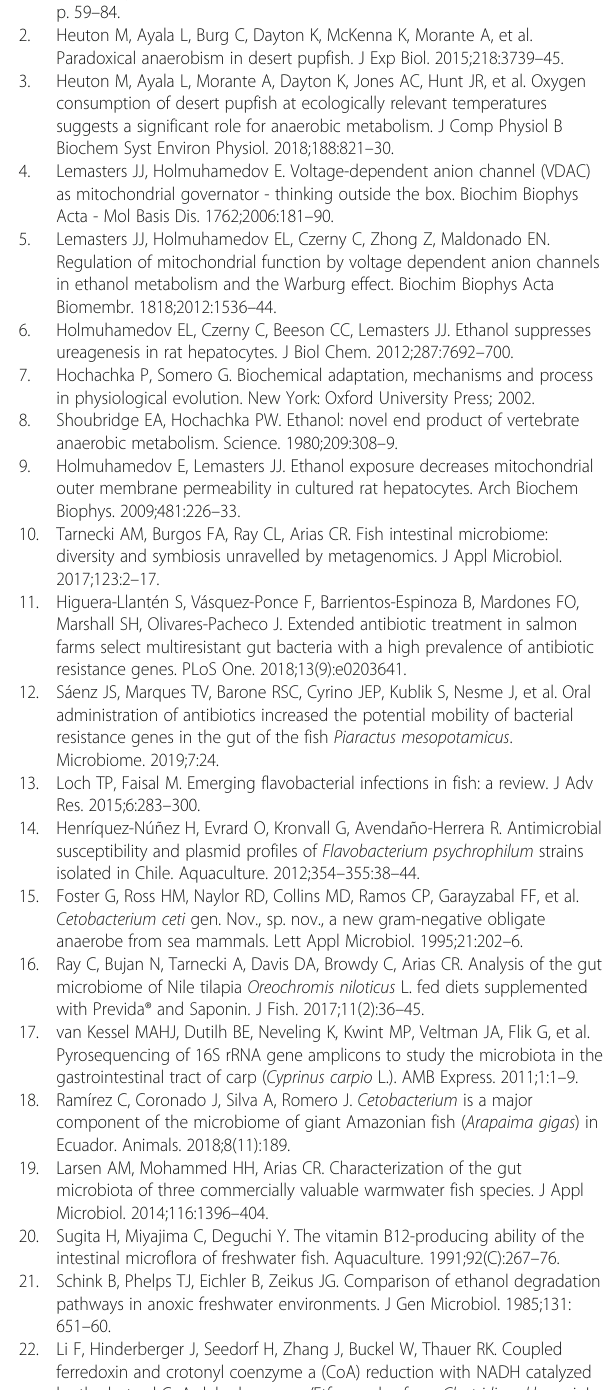
Additional file 1: Figure S1. Measurement of oxygen consumption. A schematic showing the arrangement of a glass metabolic chamber containing fish, an oxygen electrode, and peristaltic pump used to measure the oxygen consumption by pupfish. Additional file 2: Table S1. Sample Metadata. Table S2. SIMilarity PERcentage (SIMPER) analysis based on Bray-Curtis dissimilarity between antibiotic-treated and control fish. Given is the mean relative abundance in each group and cumulative contribution of nine SVs contributing to- wards 50% of dissimilarity between the